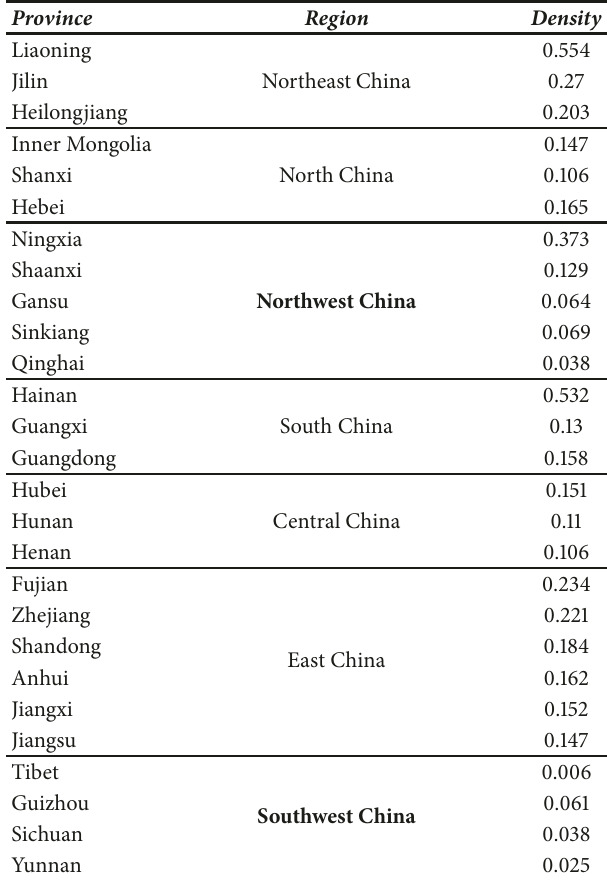
Table 1: Densities of subnetworks divided by